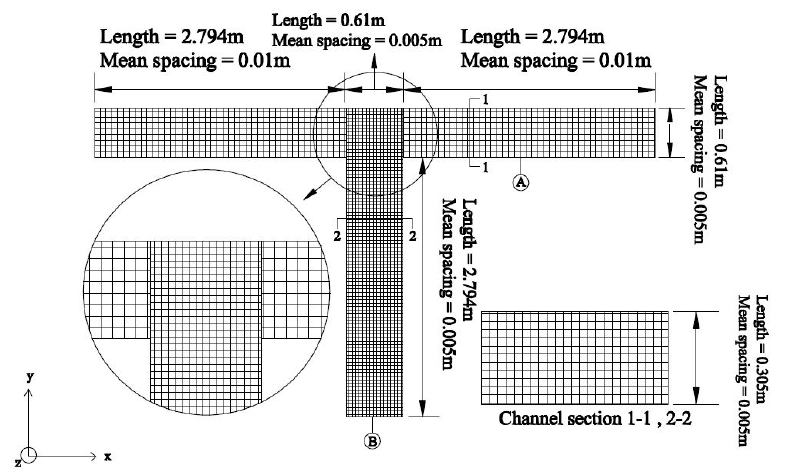
Figure 3. Gridding the plan and the cross-section of the simulated model using the ANSYS-CFX.